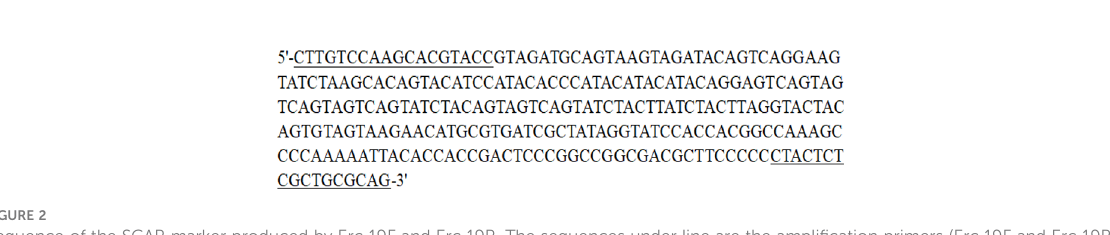
FIGURE 2 Sequence of the SCAR marker produced by Erc 19F and Erc 19R. The sequences under line are the ampli fi cation primers (Erc 19F and Erc